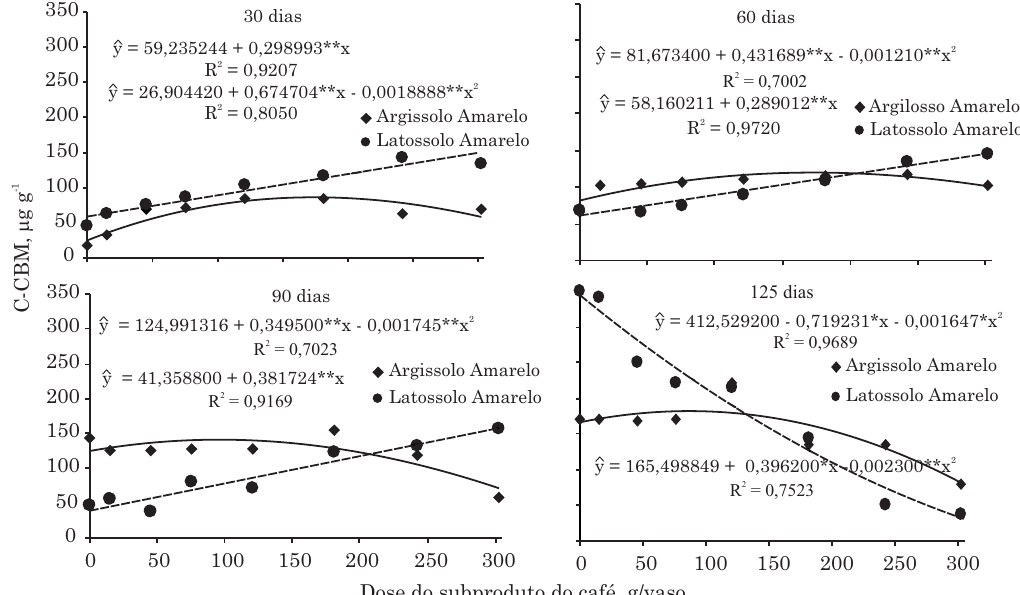
Figura 1. Carbono microbiano (C-CBM) aos 30, 60, 90 e 125 dias de incubação nas amostras do Argissolo Amarelo e Latossolo Amarelo, em função da aplicação de doses de subproduto de café e sob o cultivo de